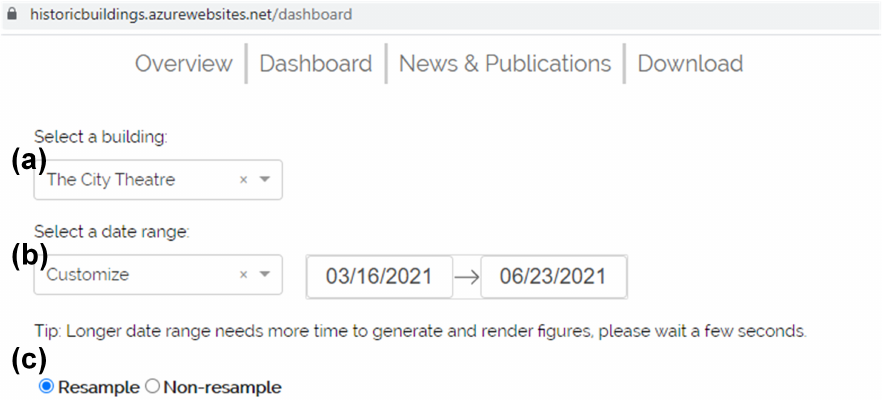
Figure 8. The dashboard provides data visualization for real-time and historical data by selecting the following: ( a ) the target building, ( b ) the target date range, and ( c ) whether to